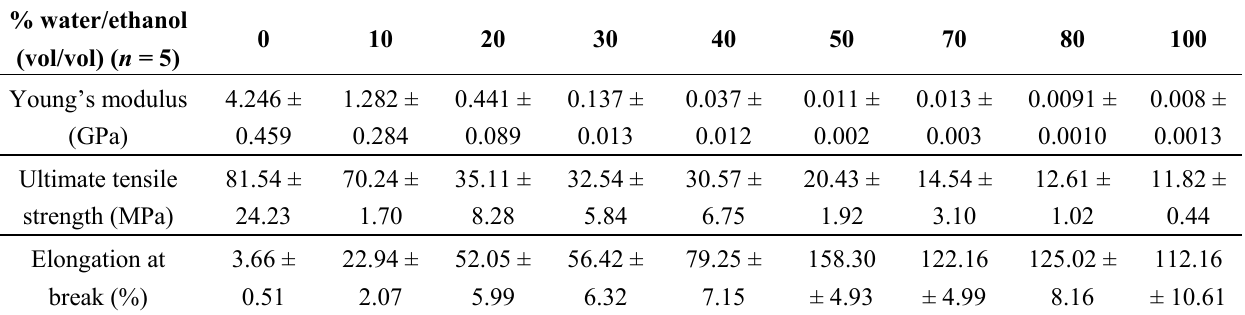
Table 1 . Mechanical properties of CHT membranes under distinct hydration